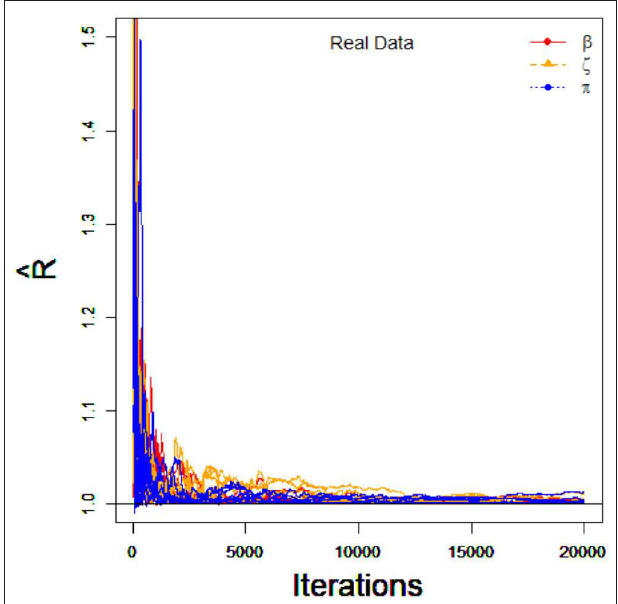
FIGURE 5 | The trace plots of PSRF values for the real